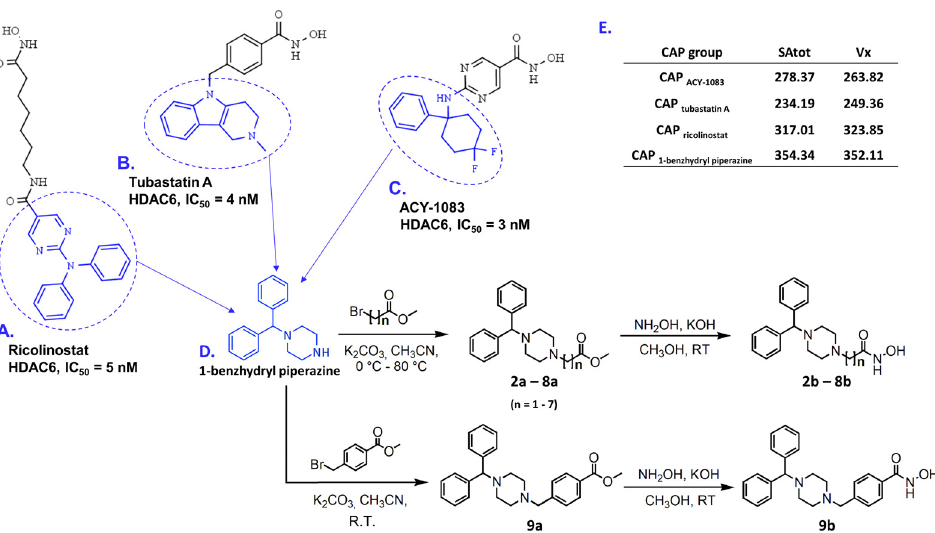
Figure 2. Examples of selective HDAC6 inhibitors: ( A ) ricolinostat, ( B ) tubastatin A, and ( C ) ACY-1083, in which CAP groups are labeled in blue; ( D ) synthetic routes to produce final products 2b – 9b starting from 1-benzhydryl piperazine (CAP group) are presented on the bottom right corner, in which n represents the number of carbon atoms in the hydrocarbon linker; ( E ) table with calculated SAtot and Vx descriptors for selected CAP groups and 1-benzhydryl piperazine as a template, presented in the right upper